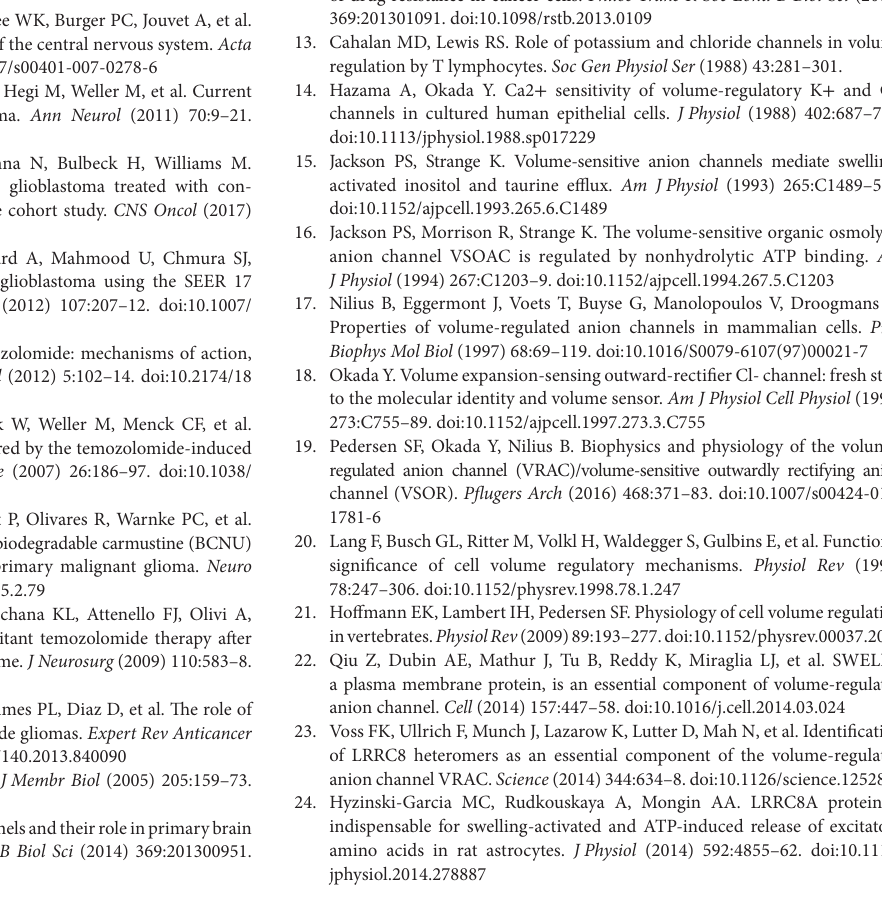
FigUre s1 | Effects of the vehicle agent dimethyl sulfoxide (DMSO) on proliferation of glioblastoma (GBM) cells. GBM cells were grown in the presence of indicated concentrations of DMSO, and their relative proliferation rates were determined 48 h after addition of the tested agent with an MTT assay. The data are the mean values ± SE of four independent experiments. * p < 0.05 vs. control cells grown in the absence of